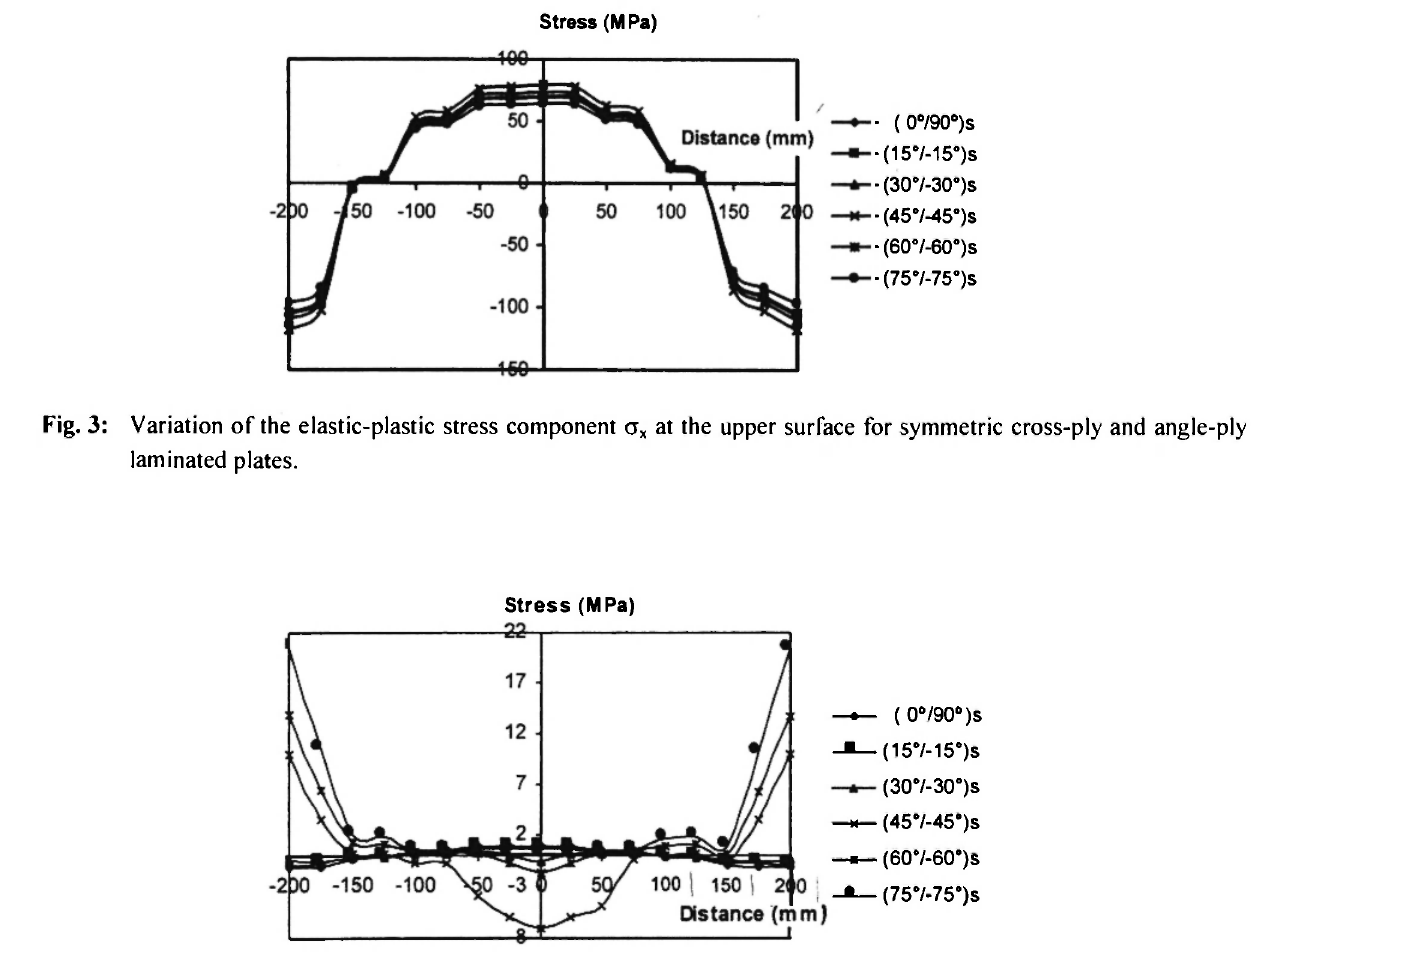
Fig. 4: Variation of the residual stress component σ χ at the upper surface for symmetric cross-ply and angle-ply laminated plates.